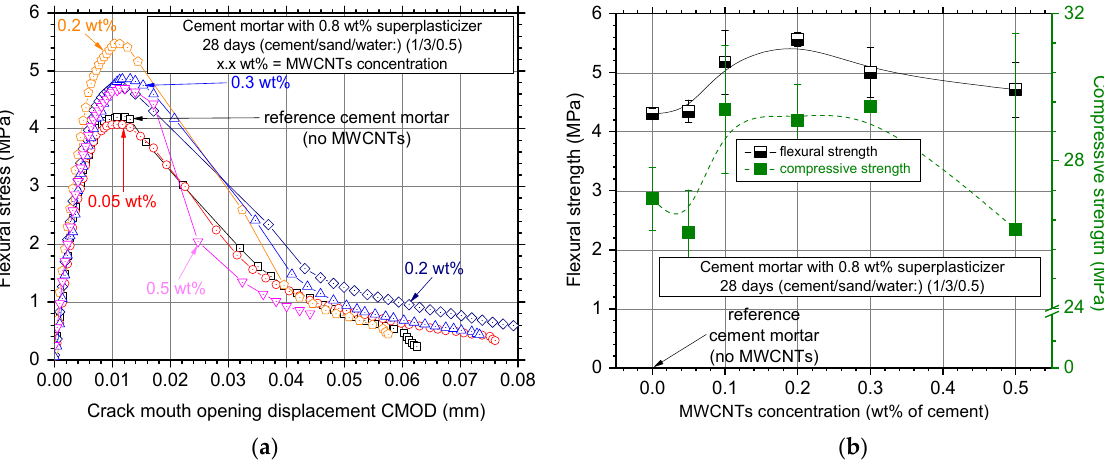
Cement mortar with 0.8 wt% superplasticizer 28 days (cement/sand/water:) (1/3/0.5)